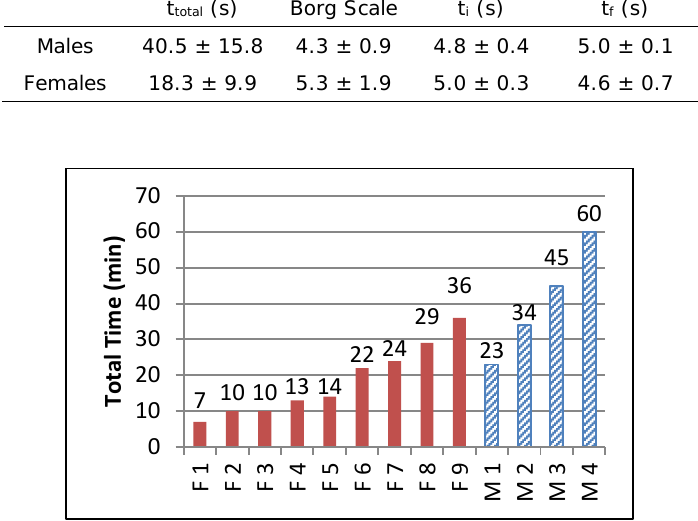
Figure 6. Total time in the experiment